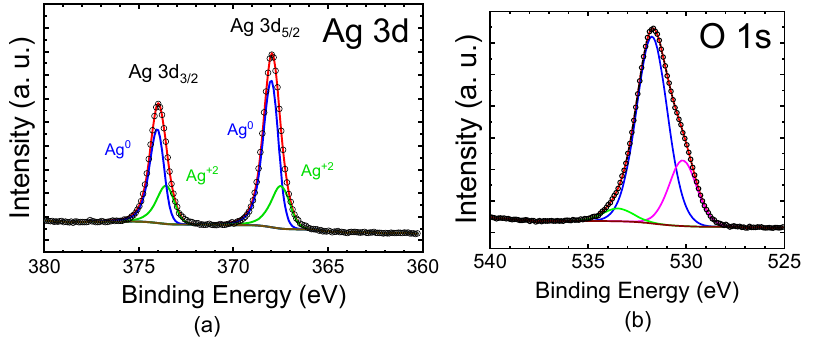
Figure 4. High ‐ resolution XPS spectra. ( a ) Ag 3d spectra show the metallic character of the surface due to strong emission from Ag as compared to Ag 2+ . ( b ) O 1s is a mixed ‐ valence state signature associated with AgO film.